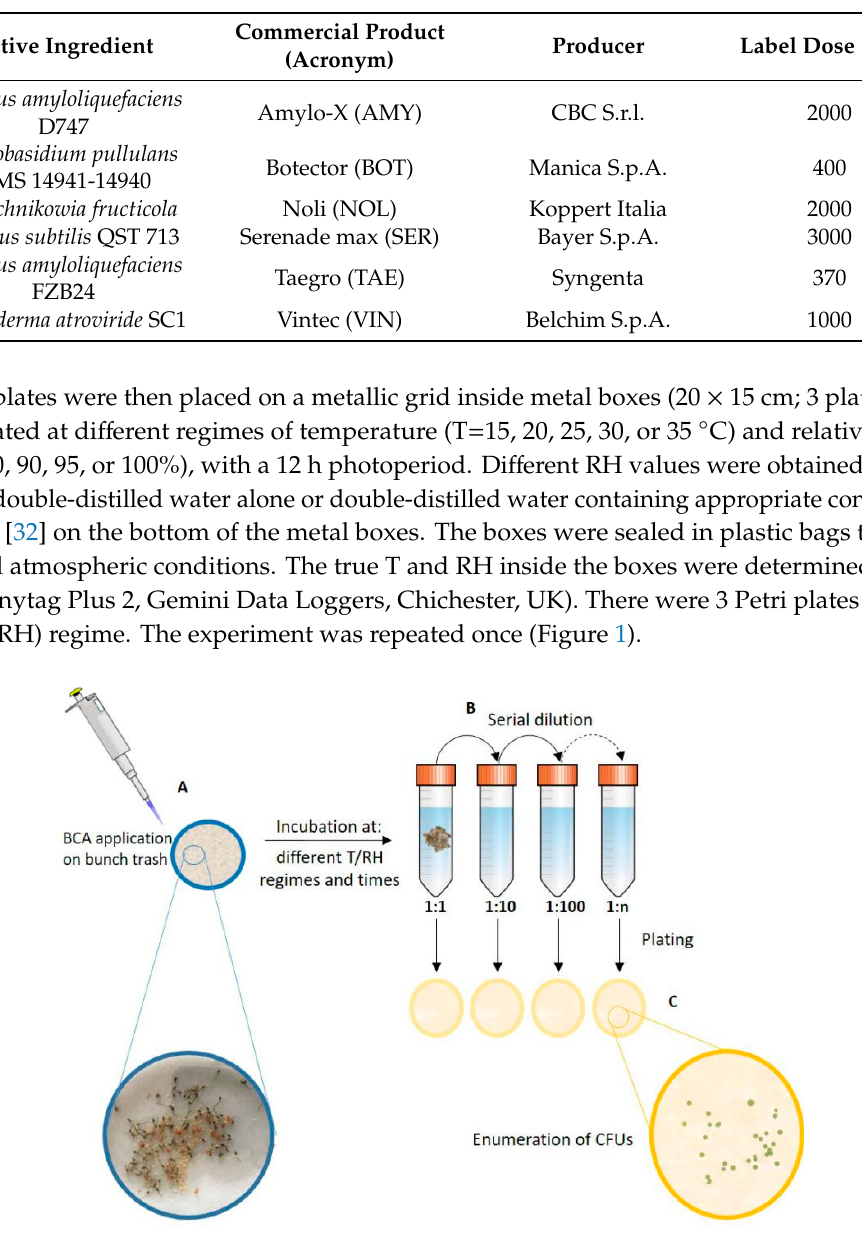
Table 1. Biocontrol agents (BCAs) used in the experiment.